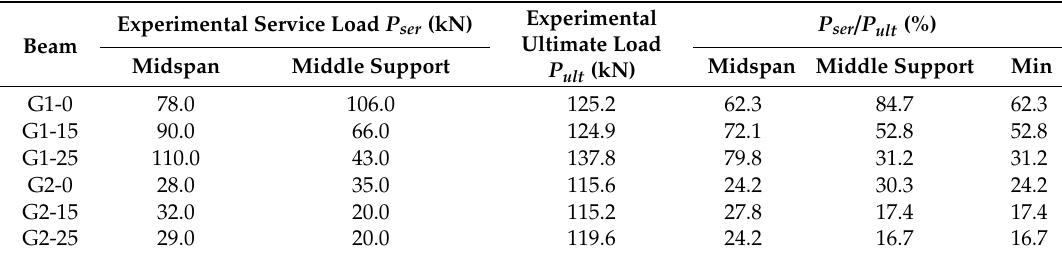
Table 5. Experimental service load for the tested beams at which the maximal crack width reaches 0.7 mm.